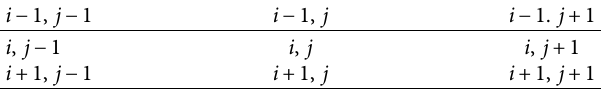
Table 1: Auxiliary matrix.